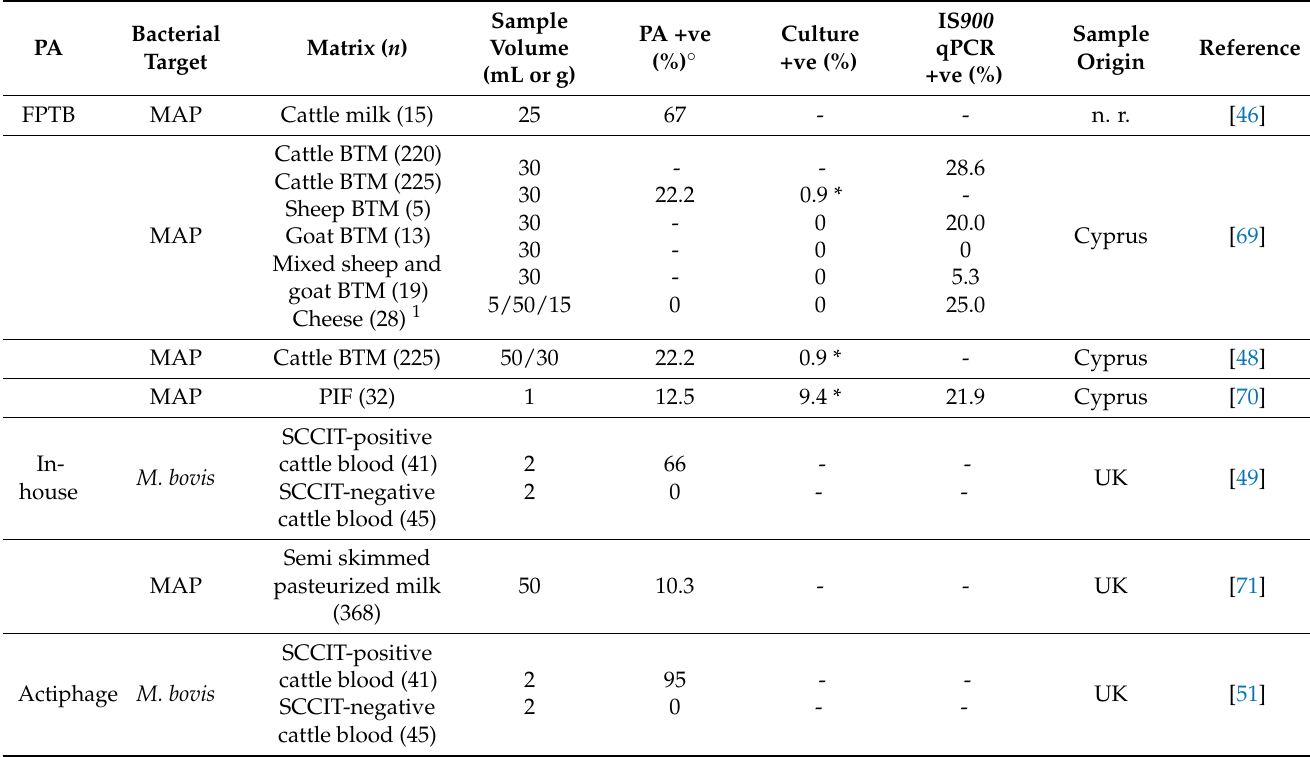
Table 3. Detection of M. avium subsp. paratuberculosis and M. bovis in real samples by phage amplification assay. Bacterial PA